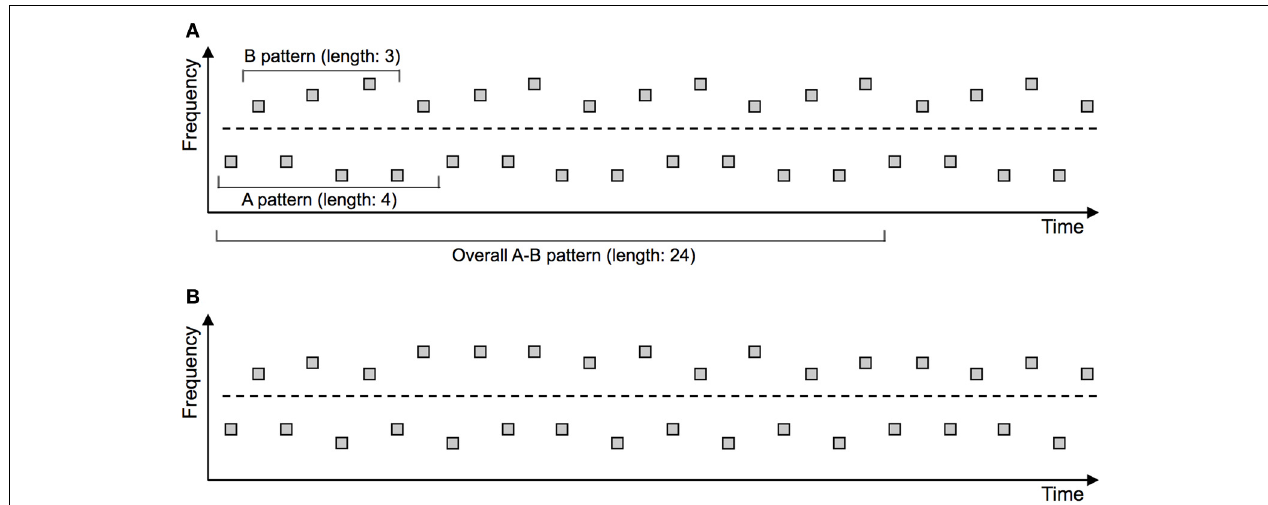
FIGURE 2 | Experimental paradigm disentangling predictability of the “Integrated” and “Segregated” perceptual organizations. The depicted stimulus arrangements are predictable (A) or unpredictable (B) with respect to stimulus frequency. The cyclically repeating (thereby predictable) frequency patterns are marked in the upper panel. The dashed line indicates the (nominal) separation between the “A” and “B” groups of tones. Critically, the number of elements included in the predictable patterns differs between the “A” and “B” group of tones. As a result, the length of the cyclically